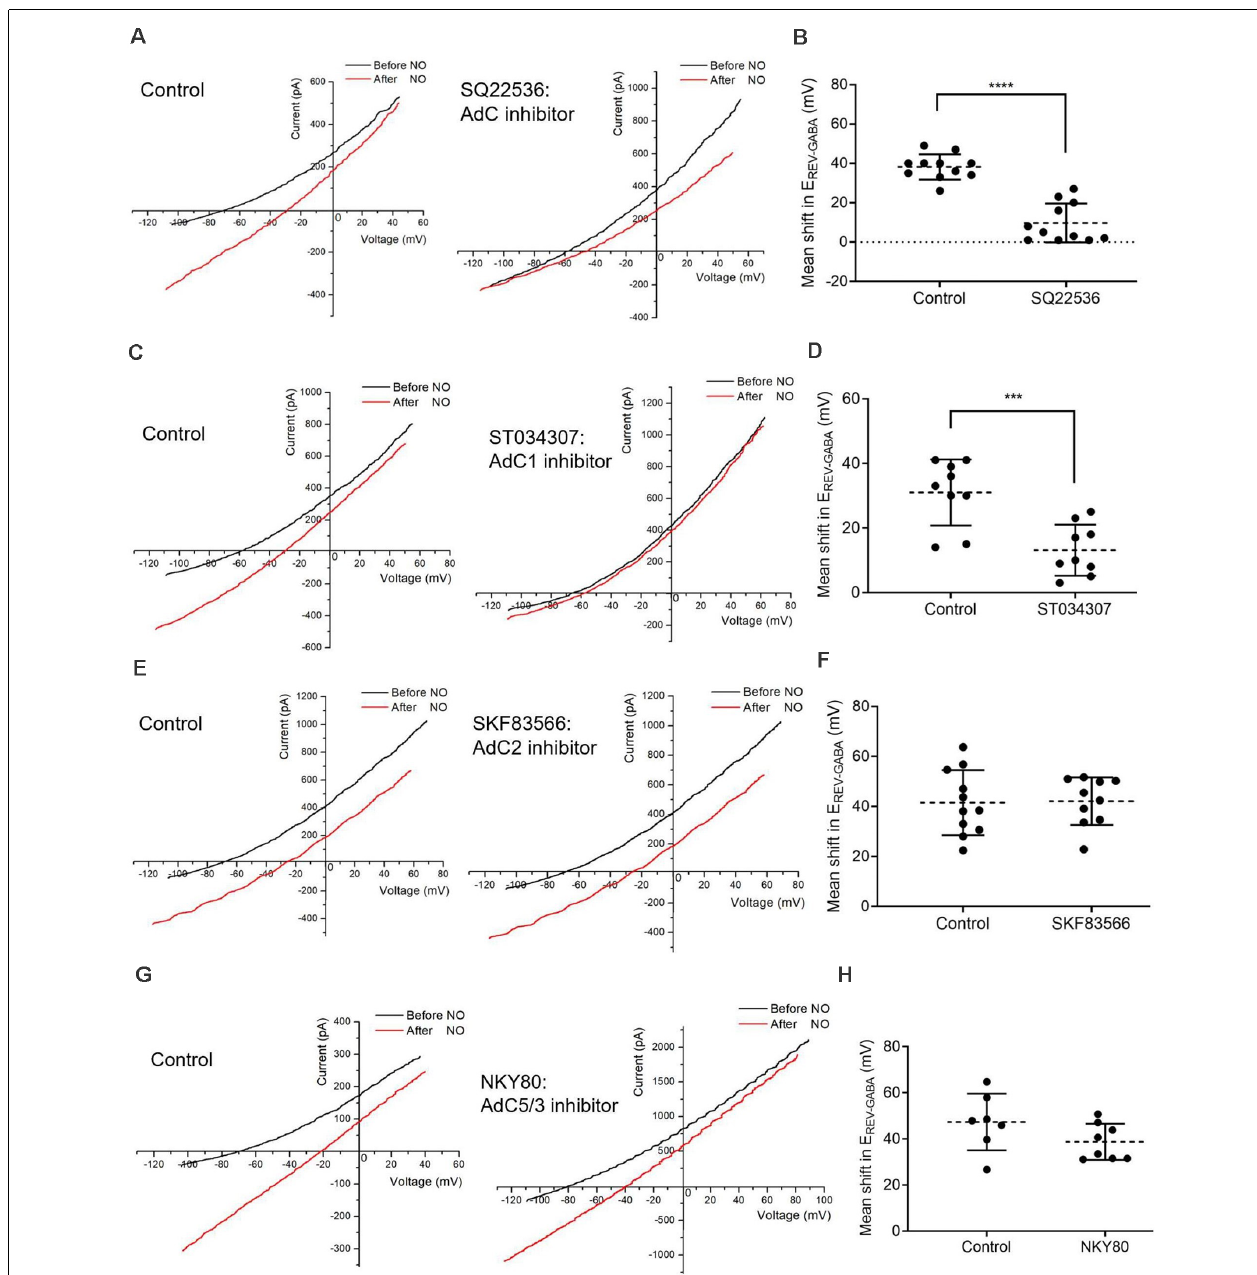
FIGURE 3 | AdC1 inhibitors suppress NO-dependent Cl − release. (A) Data from cells recorded under control condition (left) or pre-incubated with general AdC inhibitor, SQ22536 (100 nM) for 30 min (right) showing reduced shift amplitudes. (B) The quantified mean shift in E REV-GABA ± SEM; n = 11 each. **** P < 0.0001 (unpaired t -test). (C) Pre-incubation with AdC 1 inhibitor, ST034307 (100 nM) for 30 min, suppresses the NO-dependent shift in E REV-GABA . (D) The quantified mean shift in E REV-GABA ± SEM; n = 9. *** P < 0.001 (unpaired t -test). (E) Pre-incubation with the AdC 2 inhibitor, SKF83566 (10 µ M) for 20 min, does not inhibit the NO-dependent shift in E REV-GABA . (F) The quantified mean shift in E REV-GABA ± SEM; control, n = 11; SKF83566, n = 10. P = 0.91 (unpaired t -test). (G) Pre-incubation with the AdC 5/3 inhibitor, NKY80 (200 µ M) for 20 min does not block the NO-dependent shift. (H) The quantified mean shift in E REV-GABA ± SEM; control, n = 7; NKY80, n = 8. P = 0.13 (unpaired t